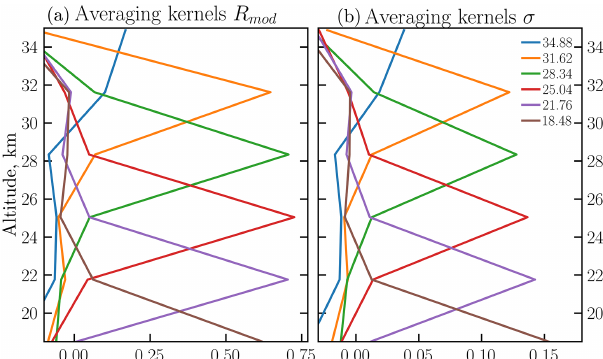
Figure 3. Averaging kernels for the aerosol particle size distribu- tion parameters: R mod (a) and σ (b) . Results were obtained using the spectra modelled with perturbation of all three parameters. The different tangent heights are colour